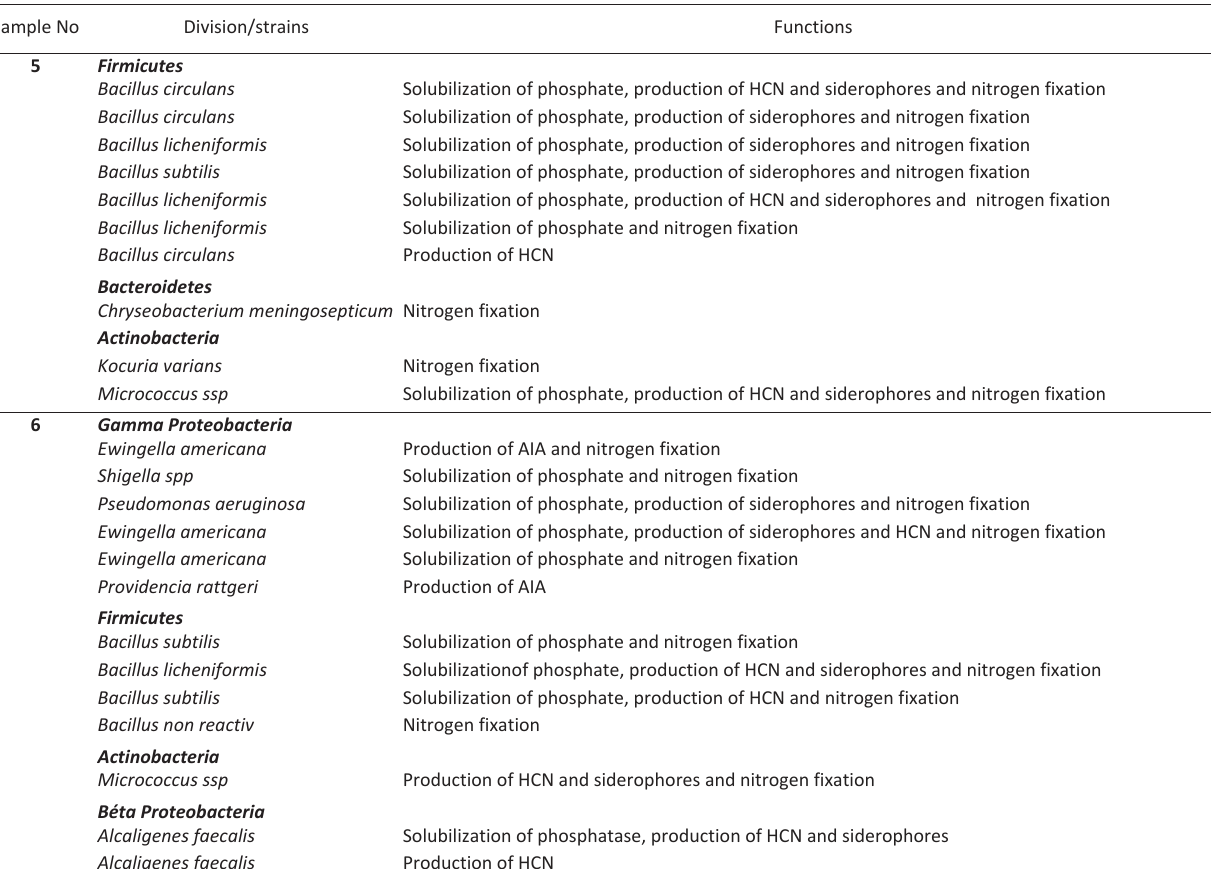
Table 1 - Functional diversity of PGPR strains isolated from ucria’s